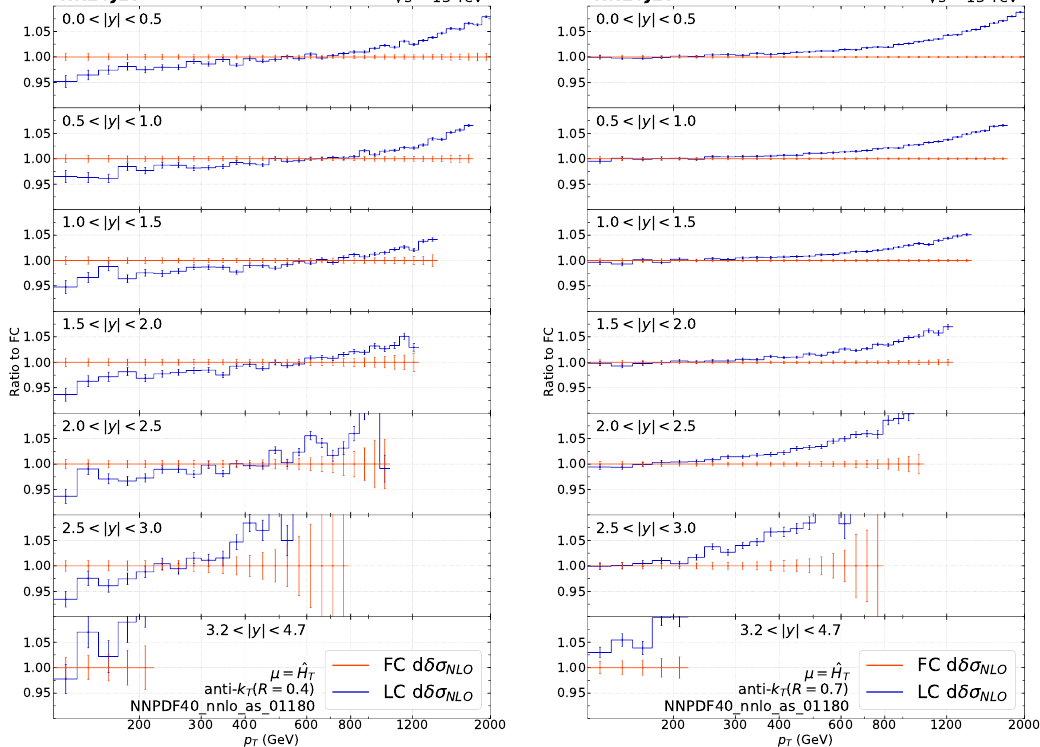
Figure 5 . NLO coefficient d δσ NLO at LC (blue) and FC (red) predictions of the R = 0 . 4 (left) and R = 0 . 7 (right) single jet inclusive cross section as function of p T for all the considered rapidity slices, normalized to the FC prediction. Ratios are evaluated at the central scale and error bars represent numerical integration errors